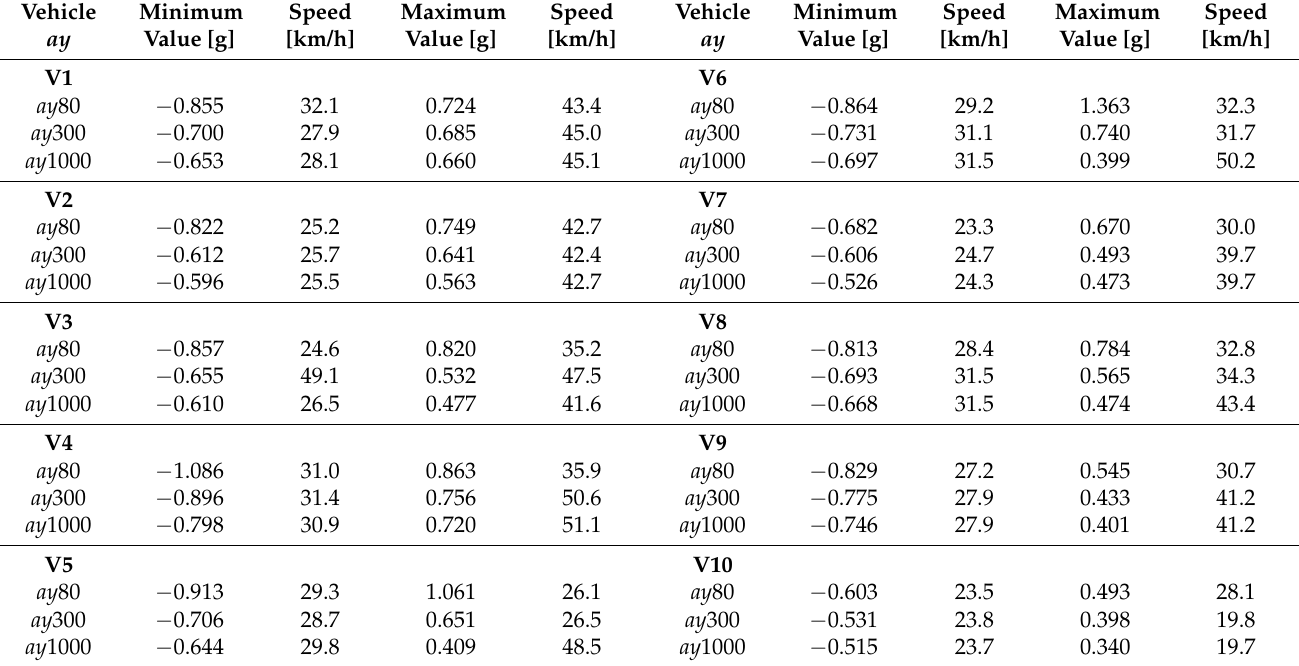
Table 5. Minimum (left curves) and maximum (right curves) lateral accelerations ay 80, ay 300, ay 1000 measured for individual tested